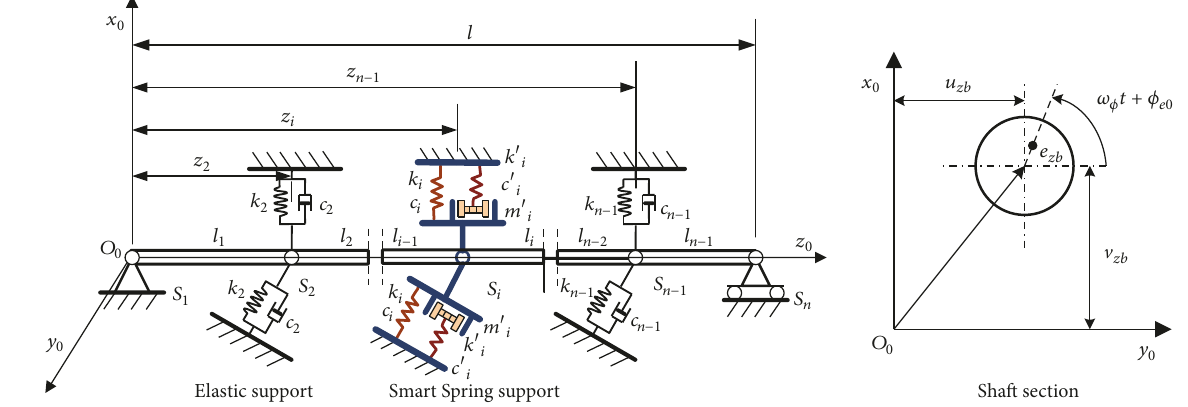
Figure 2: Flexible multispan shaft with the SMSS.